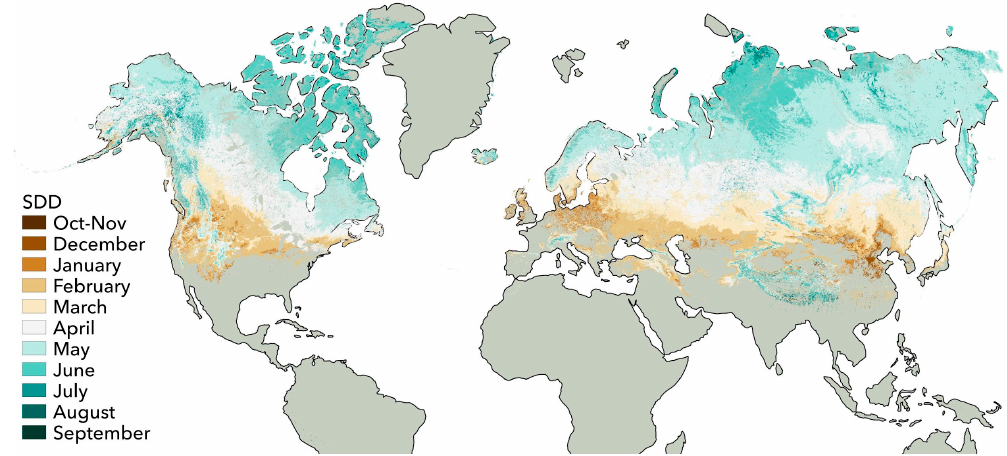
Figure 3. Northern Hemisphere snow disappearance date (SDD) aggregated to 2 km resolution for the 2016 water year generated by Google Earth Engine and the MOD10A1 snow cover area product. The SDD values represent the day of the water year that snow disappears from the landscape and are binned into months for visualization and interpretation. The Southern Hemisphere is not included because the water year date range differs by hemisphere.